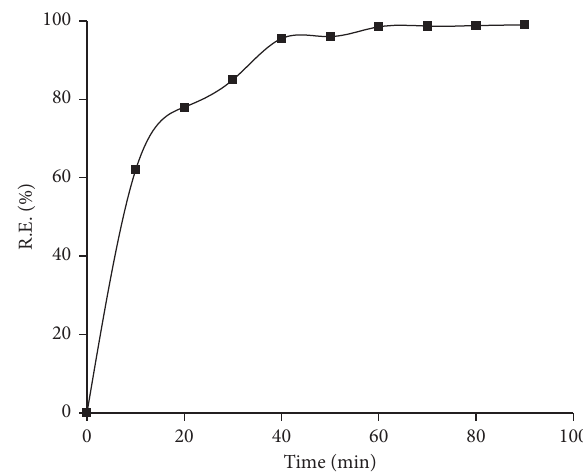
Figure 3: Color removal efficiency with